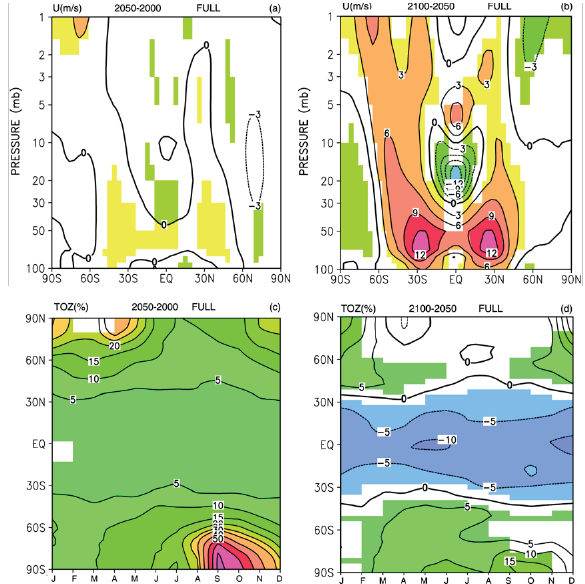
Fig. 5. Zonal and ensemble mean RES term (see the Eq. 1) for the changes of (a) annual mean temperature (K); (b) annual mean zonal wind (ms − 1 ); (c) annual mean ozone mixing ratio (%); (d) total column ozone (%) from 2000 to 2100. Color pattern indicates the regions where the changes are judged statistically significant at or better than 5% level.